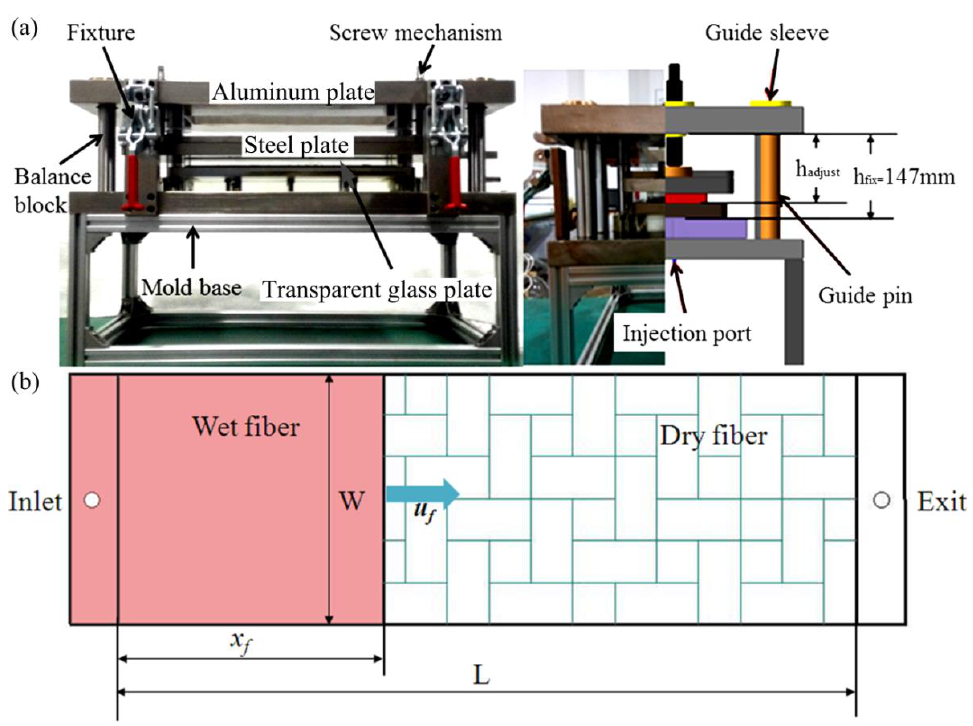
Figure 2. ( a ) Permeability test mold (front view and side view) and ( b ) schematic of permeability test.